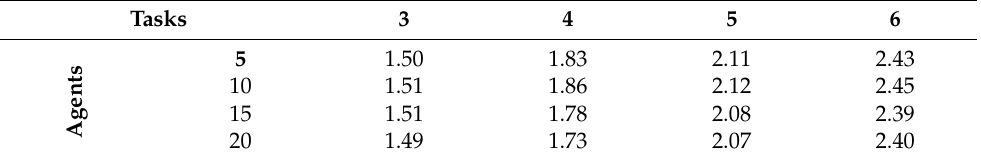
Table 8. Mean Improvement in Acceptable TBRM States per MAS (Scenario 3).